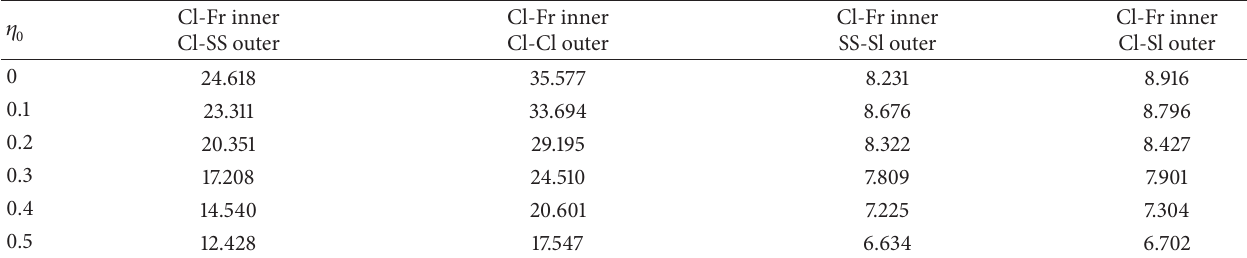
Table 13: Fundamental frequency of vibration 𝜆 1 of DWCNTs with different boundary conditions between inner and outer tubes and for [ 0.1–0.5 ] 𝜂 0